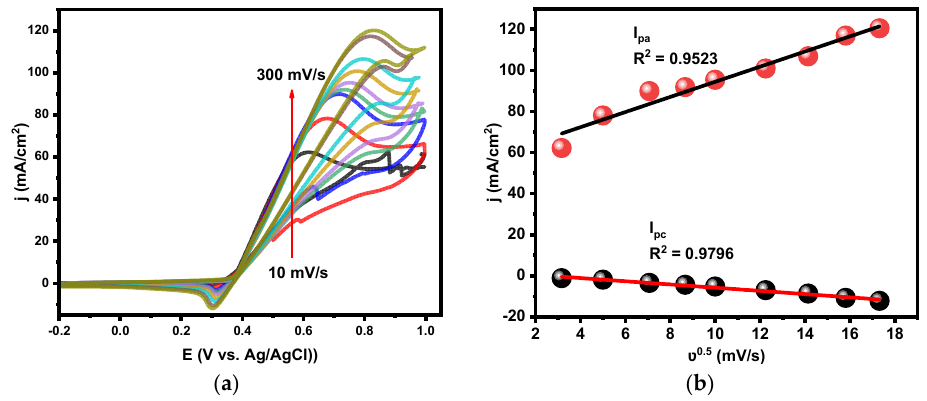
Figure 6. ( a ) CV curves of NiNPs@PCFs in the presence of 0.5 M CH 3 OH and 1.0 M KOH at different potential scan rates and ( b ) linear fitting of the cathodic (I cp ) and anodic (I pa ) peak current densities vs. the square roots of the scan rates.